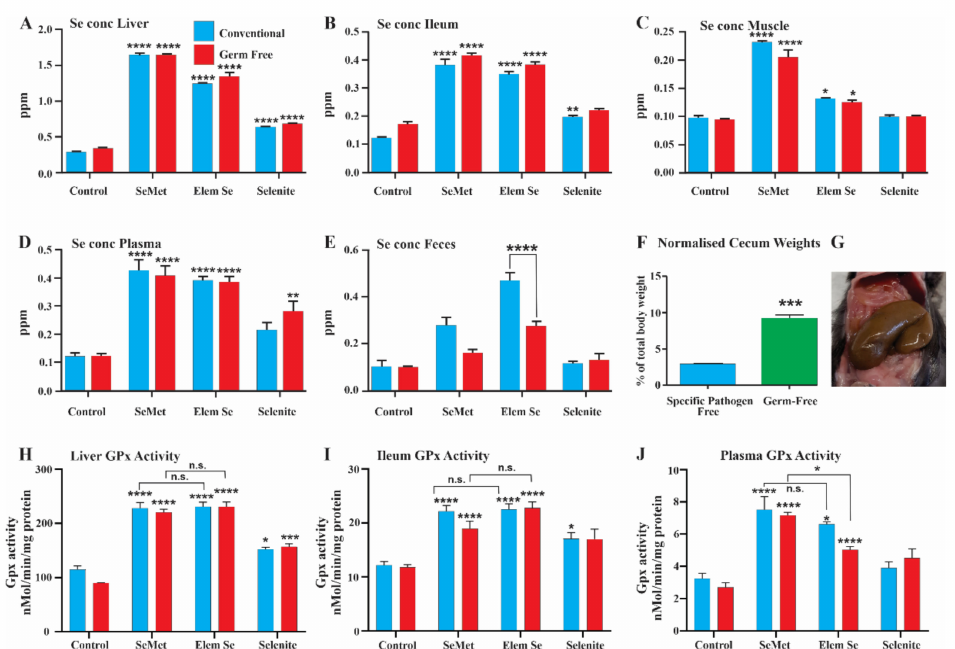
Figure 5. ( A – E ): Selenium concentrations in liver, ileum, muscle, plasma and feces of mice after supplementing feed of conventional and germ-free mice with 0.3 ppm organic Se (SeMet), inorganic Se (Selenite) or nanoelemental Se (Elem Se). Se measured by mass spectrometry. ( H – J ): GPx activity in the liver, ileum and plasma after feeding mice with diets containing 0.3 ppm Se derived from different formulations; organic, inorganic or nanoelemental Se. ( F , G ): Cecum weights. ( F ) shows the difference in cecum weights between SPF and GF mice, relative to overall body weight. Non- parametric unpaired t-test comparing ranks (Mann–Whitney test), p < 0.0001. ( G ) shows a photograph of enlarged cecum of a GF animal. ( A – E , H – J ). One-way ANOVA was carried out with Tuckey’s multiple comparisons between groups, statistical significance was measured relative to control fed mice in GF and SPF groups. Data is presented as mean ± SEM. p < 0.05 *, p < 0.01 **, p < 0.001 ***, p < 0.0001